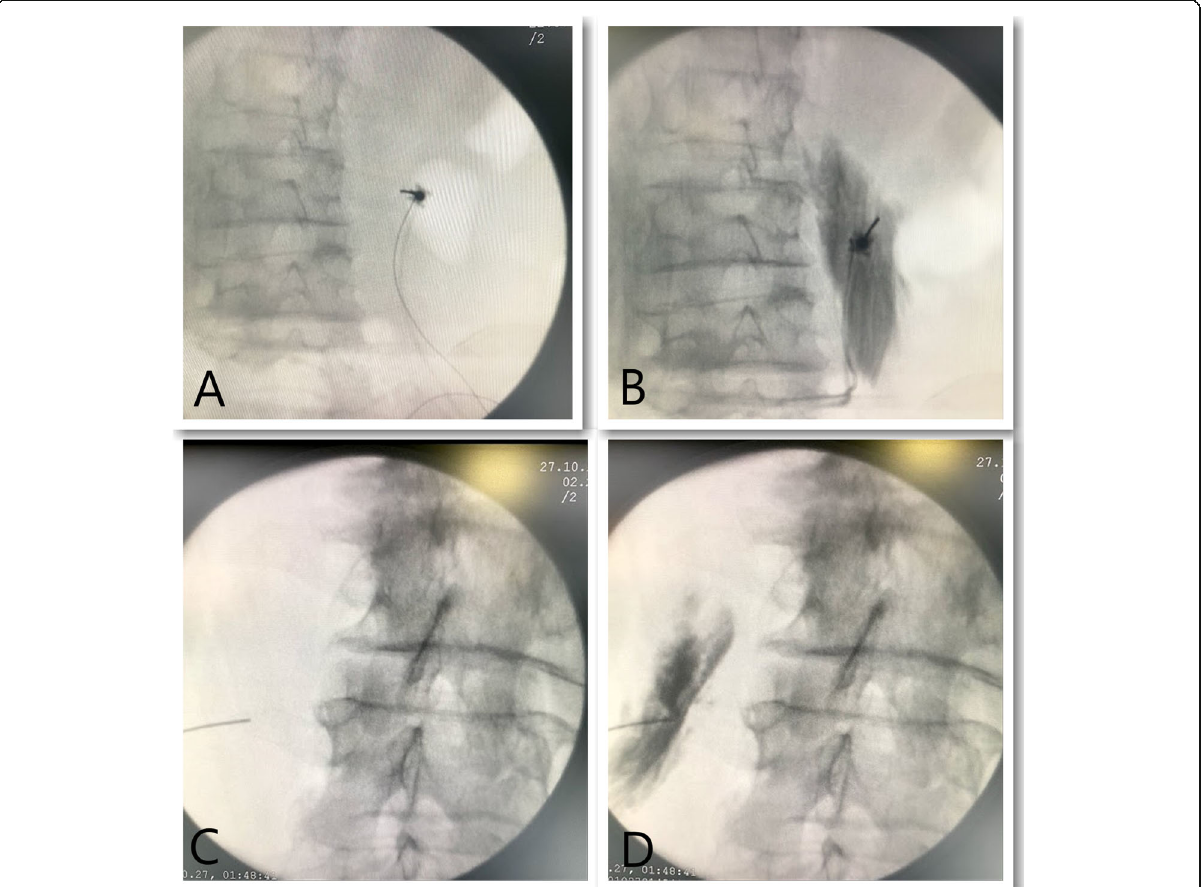
Fig. 3 A X-ray showing contact of the needle in the middle of the transverse process. B Contrast spread close to paravertebral space. C Needle contacting the lower border of the transverse process. D Contrast spread along with the psoas muscle towards lumbar plexus. TP — transverse